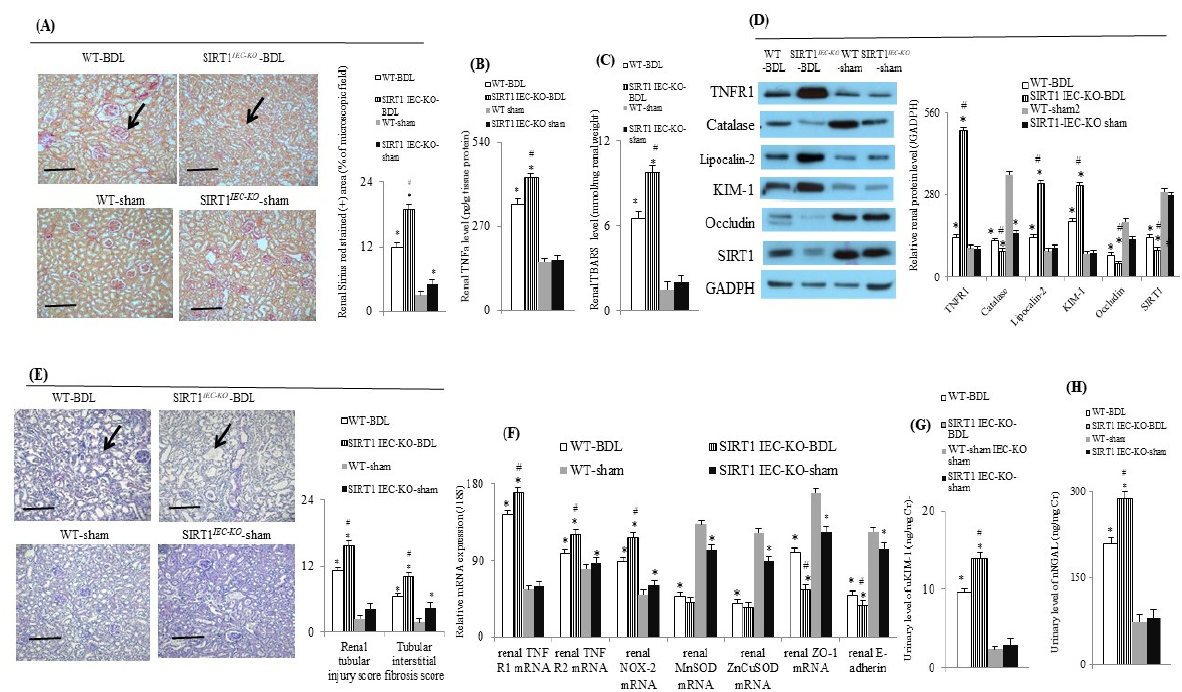
Figure 3. Intestinal SIRT1 deficiency increased renal TNF α -related inflammatory and oxidative stress-related markers. ( A ) Representative image and bar graphs of Sirius red staining (+) (arrowhead) of mice renal section (20 × , the scale bar is 100 µ m); ( B ) renal TNF α and ( C ) TBARS levels, ( D ) representative images and bar graphs of various renal TNF α -related beneficial and pathogenic proteins and ( F ) genes; ( E ) representative H-E staining image and bar graphs of mice renal section (20 × , the scale bar is 100 µ m) for the severity of renal injury (arrowhead); urinary levels of ( G ) KIM-1 and ( H ) NGAL among groups. TBARS: thiobarbituric acid-reacting substances. * vs. WT-sham mice; # vs. WT-BDL mice.